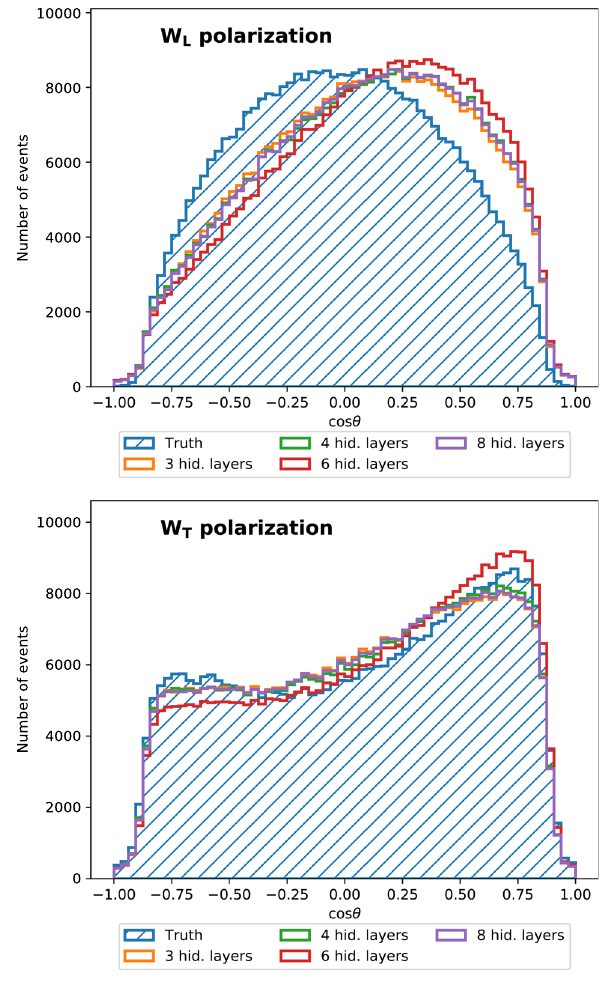
Fig. 10 Angular distribution in the W boson rest frame as a func- tion of cos ϑ , obtained using the binary classification technique, in the semi-leptonic channel. Parton-level (truth) distributions are shown for comparison, using the generator-level (true) cos ϑ . The top plot shows results obtained assuming the purely longitudinal (W L ) and the bottom plot the purely transverse (W T ) scenario. The results for a DNN with a fixed number of neurons (60) and different hidden-layer configurations are